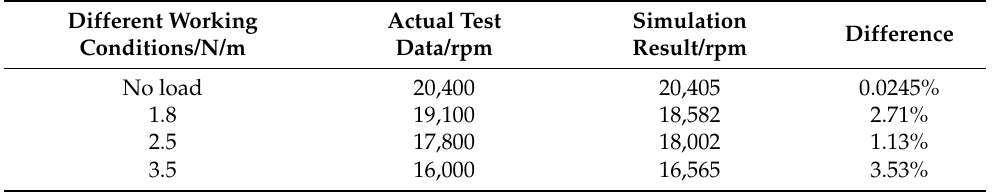
Table 4. Comparison of motor speed under different load conditions.